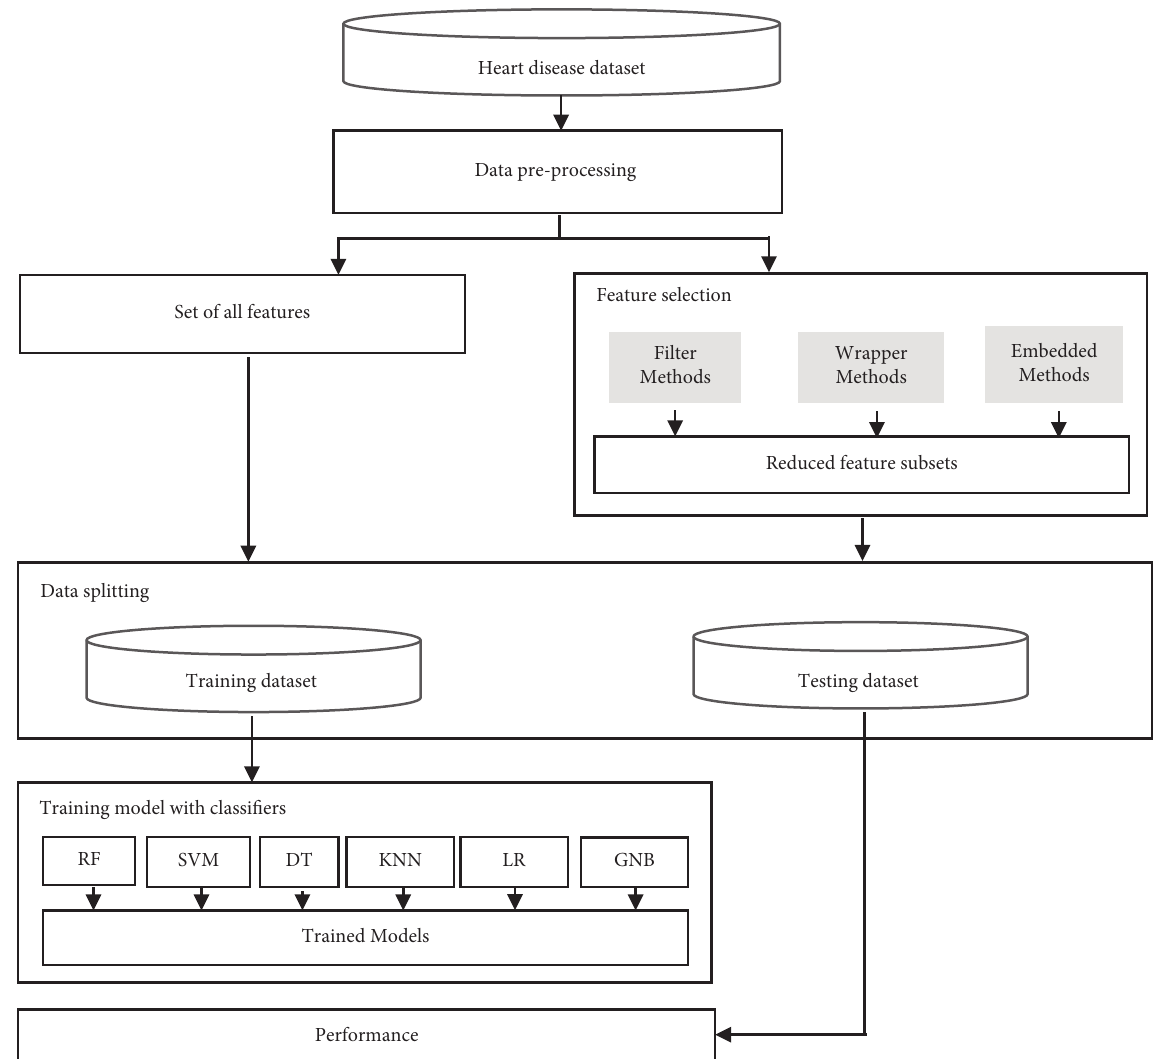
Figure 1: System